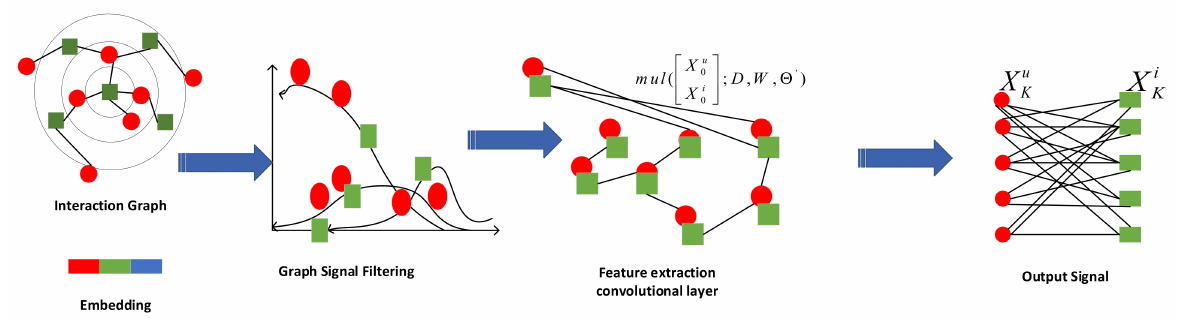
Figure 2. RW-GCF convolutional signal processing flow